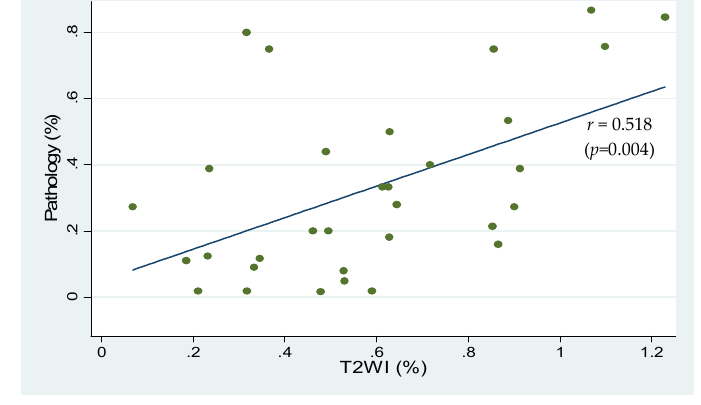
Figure A2. Graphs showing the relationship between pathologic and imaging findings regarding myometrial invasion. The correlation coe ffi cient for contrast-enhanced T1w ( A ) and T2w ( B ) of a patient without uterine leiomyoma is 0.538 and 0.518,